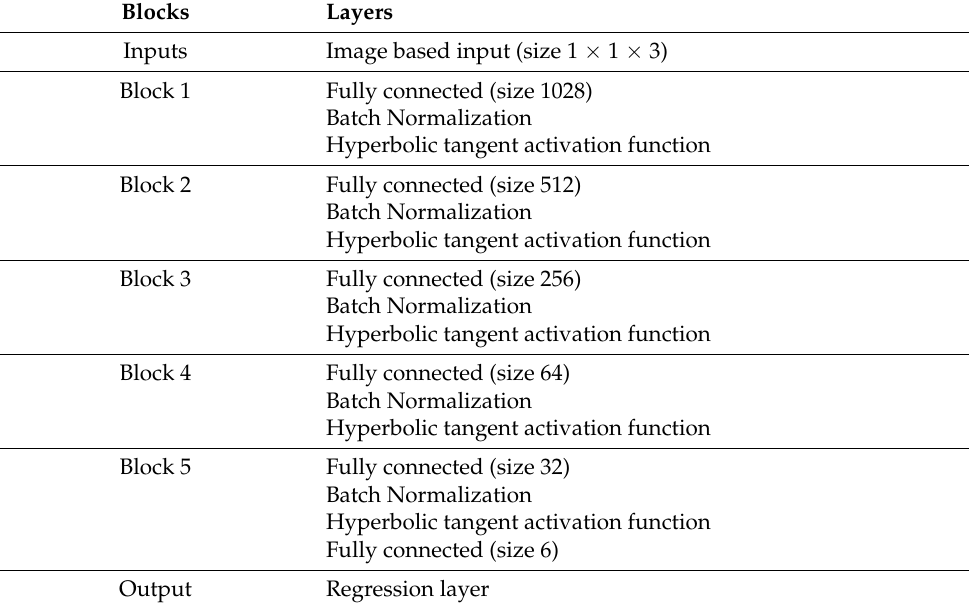
Table 1. Architecture of the